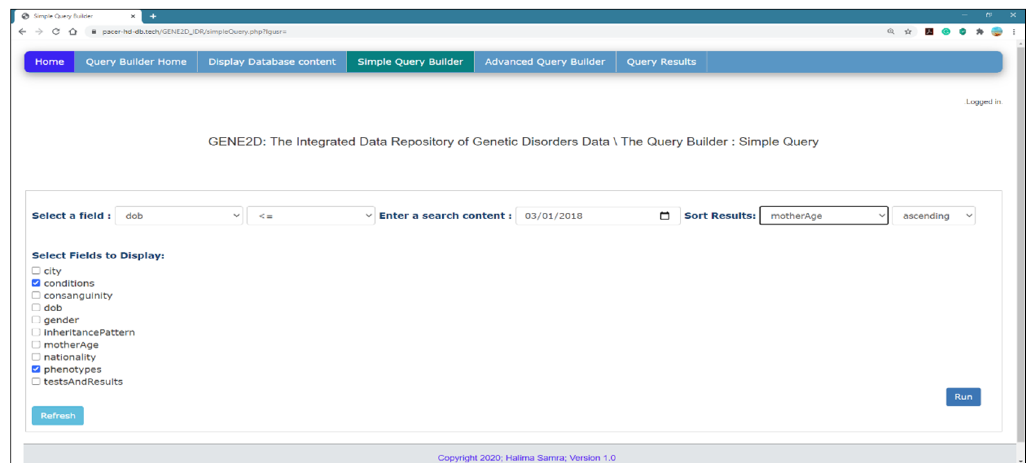
Figure 7. The Simple Query Builder page.